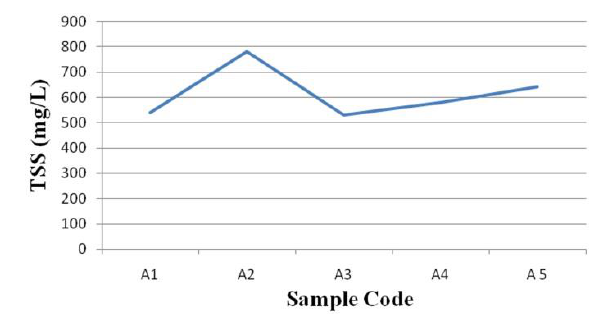
Figure 4. TSS in samples